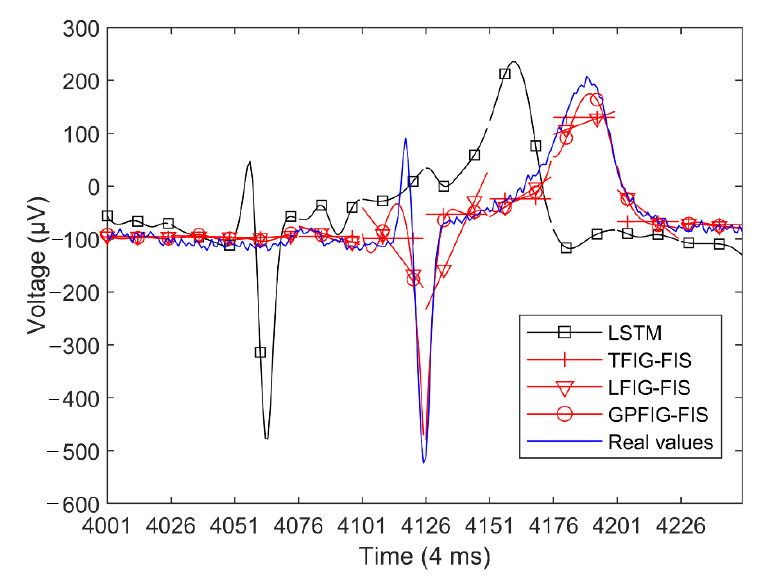
Figure 14. Electrocardiogram prediction results.